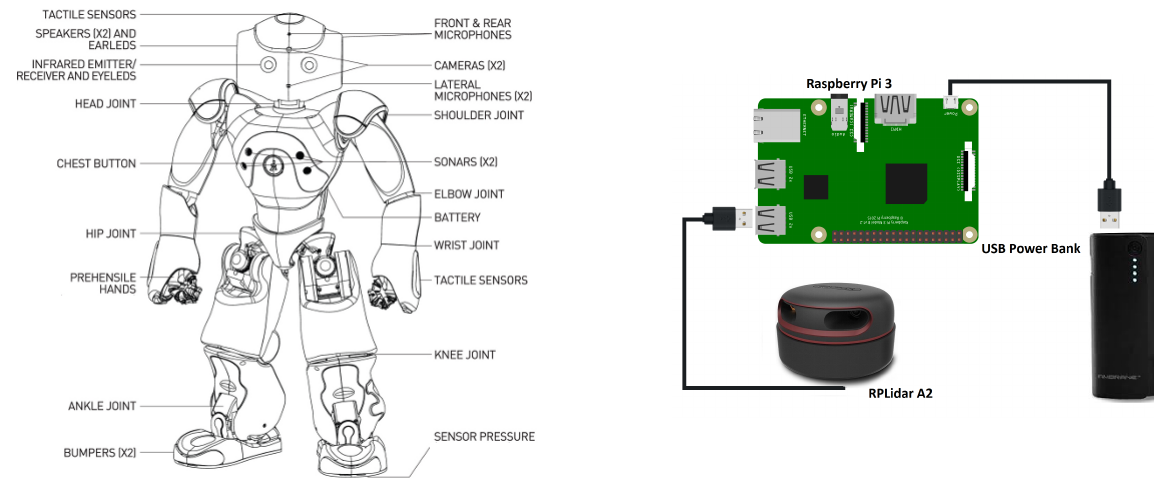
Figure 2. Hardware configuration: The Nao robot, its components and the connection scheme of the RPLidar A2 module and Raspberry Pi